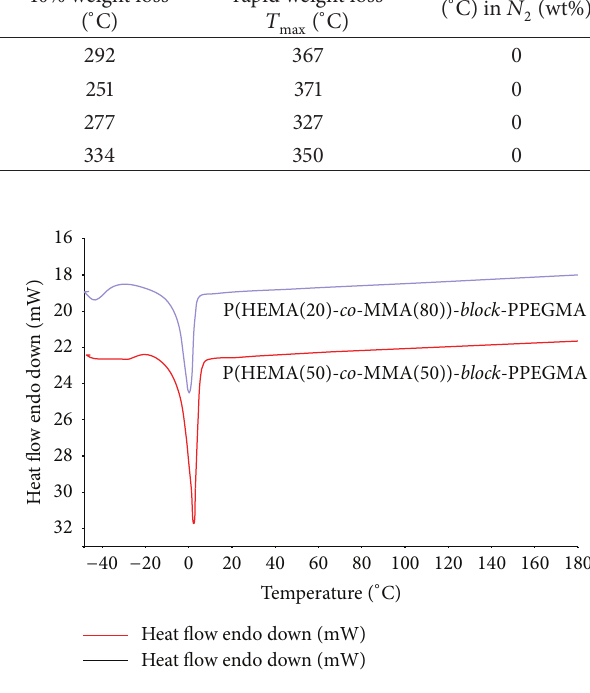
Figure 7: The DSC of P(HEMA- co -MMA)- block -PPEGMA ( 2b, 2d ).